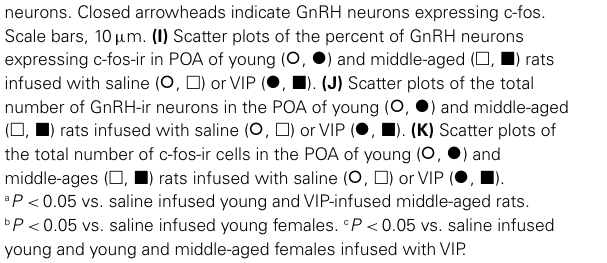
neurons. Closed arrowheads indicate GnRH neurons expressing c-fos. Scale bars, 10 μ m. (I) Scatter plots of the percent of GnRH neurons ◦ • expressing c-fos-ir in POA of young ( , ) and middle-aged ( (cid:3) , (cid:2) )